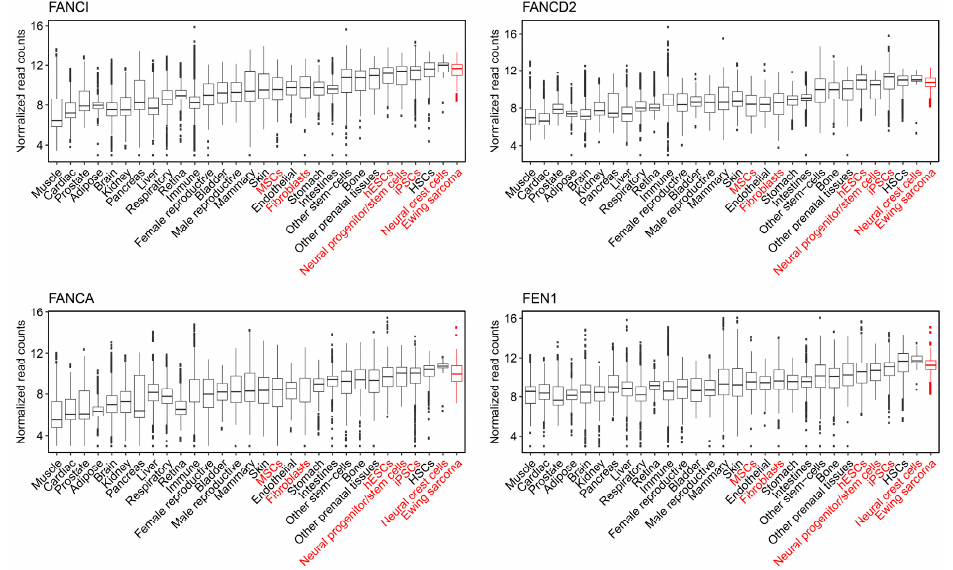
Figure 8. Normalized expression of Fanconi Anemia and flap endonuclease genes across normal tissue types and Ewing